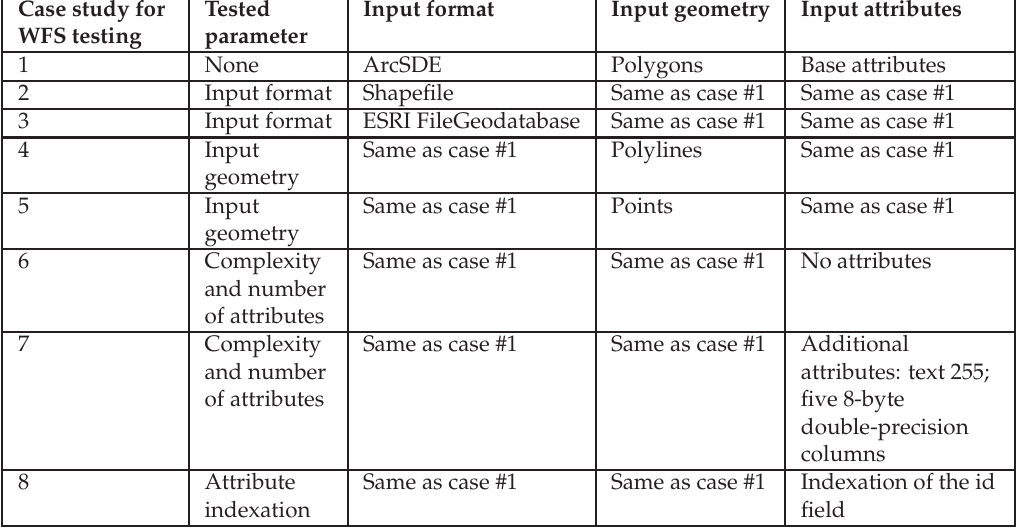
Table 2: Summary of the WFS testing scenarios. Case #1 is the “base case.”